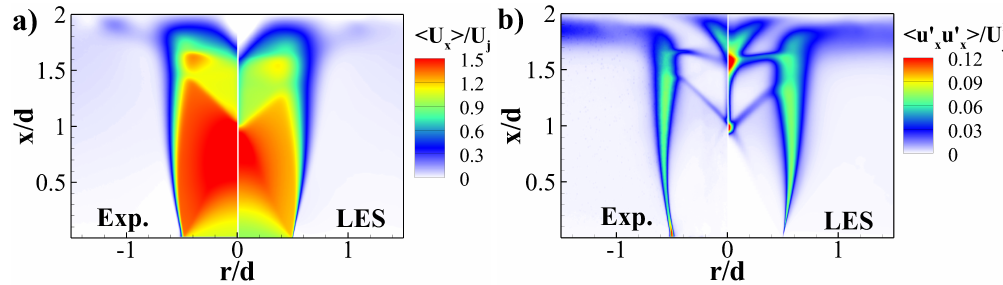
Figure 4. ( a ) Mean streamwise velocity field and ( b ) twice of streamwise turbulent kinetic energy of the large eddy simulation (LES) (right) and the experimental results of Weightman et al. [21] (left).